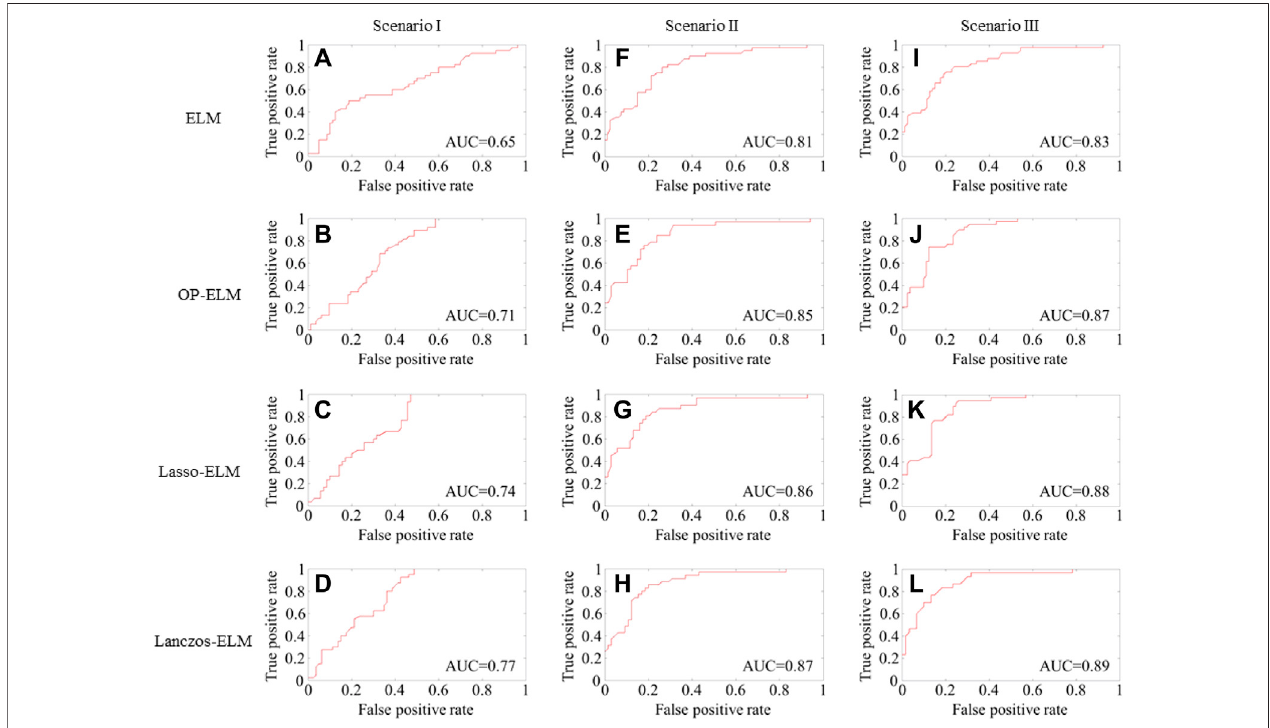
FIGURE 6 | Predictive performance of building structural-damage risk classi fi cation